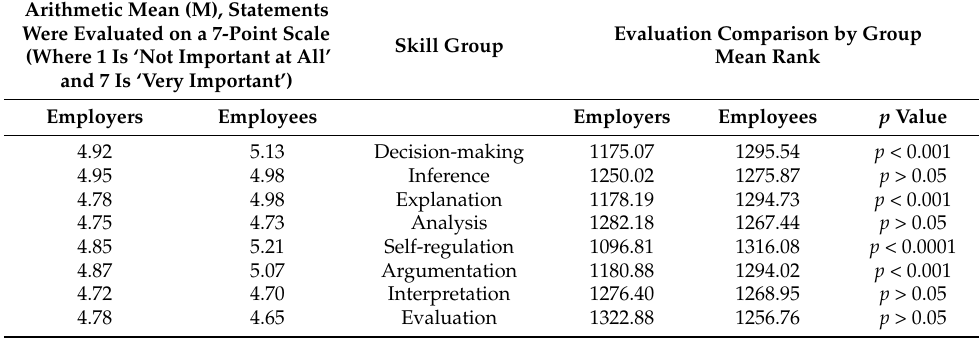
Table 5. Evaluation of the need to improve critical thinking skills/evaluation comparison by